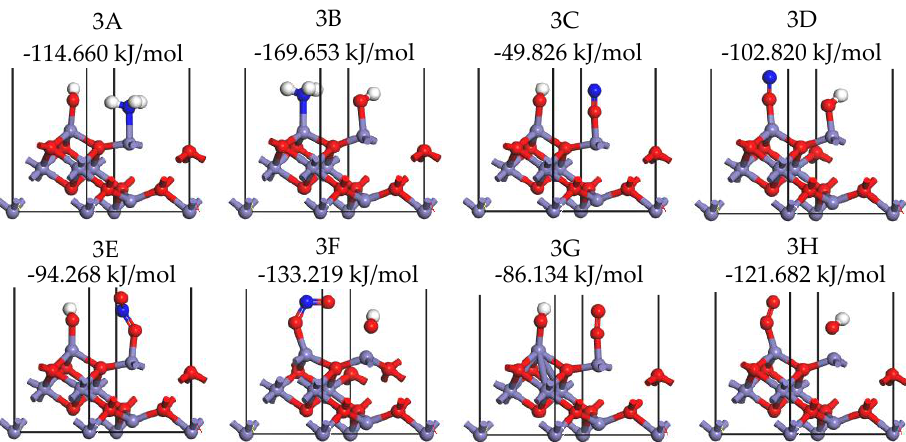
Figure 11. Stable adsorption configurations of NH 3 on the -OH pre-adsorbed γ -Fe 2 O 3 (111) surface (N, blue; Fe, purple; H, white; O, red).